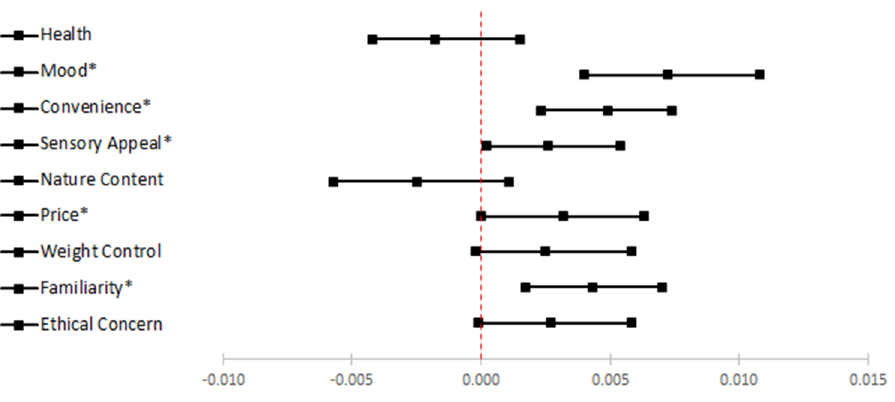
Figure 2. Forest plot for the mediation results.